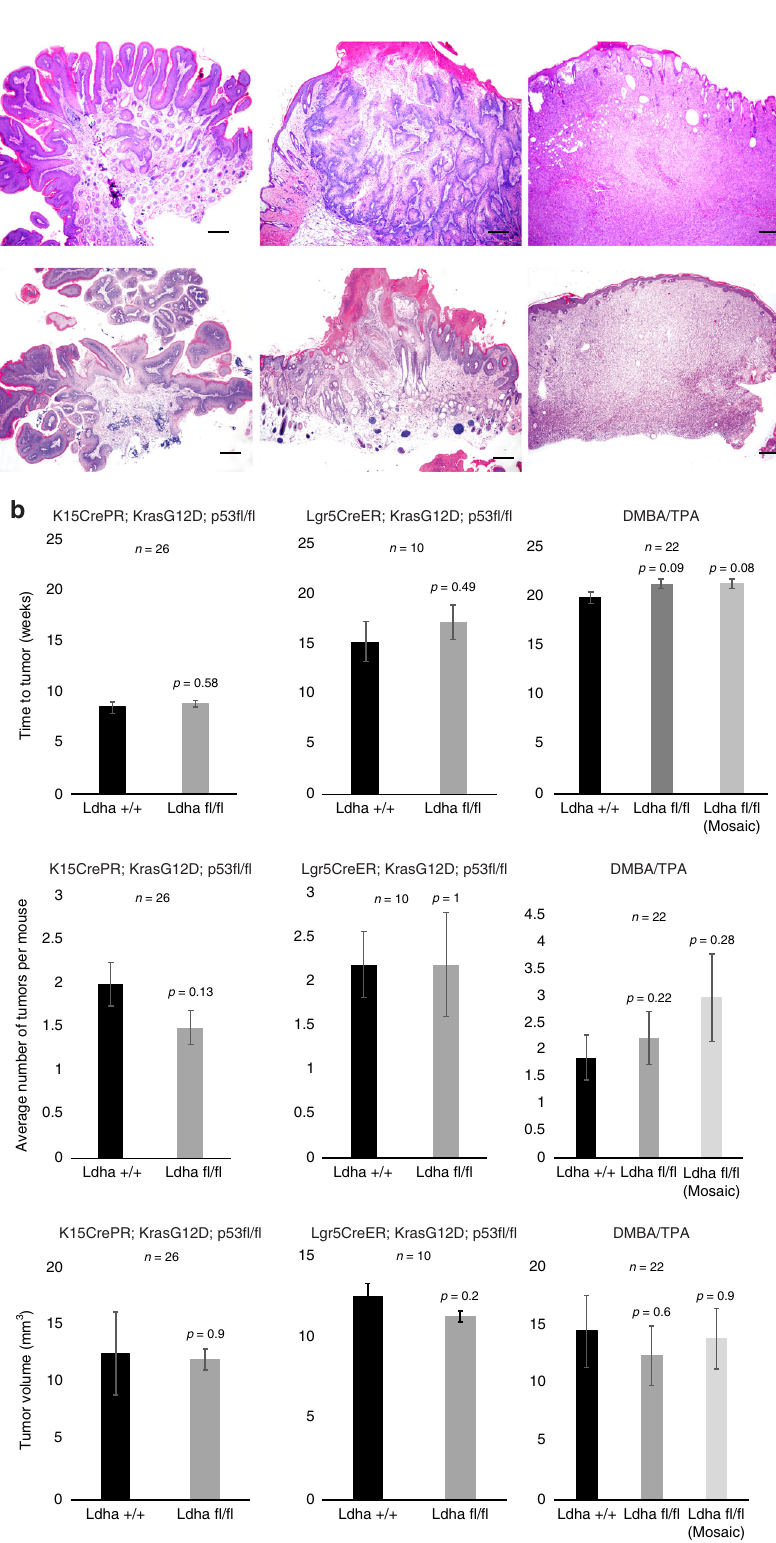
Fig. 2 Loss of Ldha does not affect tumor initiation, progression or pathology. a Pathology of Kras G12D/ p53 induced tumors from HFSCs with and without Ldha deletion appear indistinguishable across tumorigenesis. Scale bars, 200 µ m. b Quanti fi cation of time to tumor formation (left), the number of tumors formed, or the tumor volume showed no signi fi cant difference between Ldha expressing vs. Ldha deleted tumors. Also shown is results from animals where Kras G12D/ p53 was generated under the control of the Lgr5CreER , or in independent experiments where chemical carcinogenesis (DMBA/TPA) was carried out. Each bar represents the average across indicated values for n . Shown as mean ± SEM. Paired t test was performed, P < 0.05 shown for each genotype versus wild-type